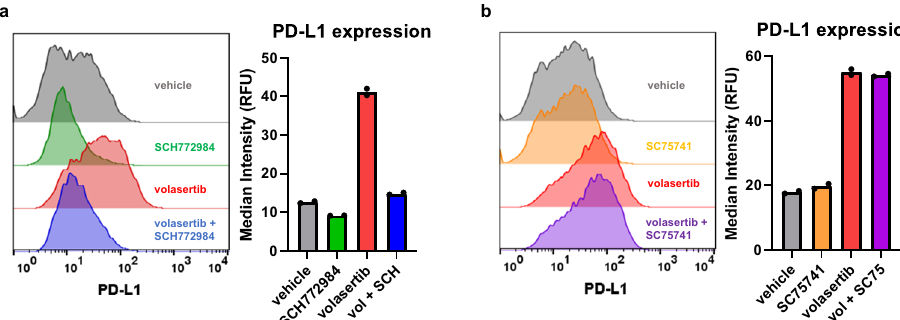
Fig. 2 Volasertib-induced PD-L1 upregulation is dependent on MAPK. a PD-L1 surface expression of NSCLC cells (H460) treated with vehicle control (0.1% DMSO in PBS), SCH772984 (ERK1/2 small molecule inhibitor, 1 μ M), volasertib (100 nM), or SCH772984 (SCH; 1 μ M) + volasertib (vol; 100 nM) – (left) representative histograms, (right) MFI quanti fi cation. Data presented as mean MFI (median fl uorescent Intensity) from biological duplicates, 10,000 events collected per sample. b PD-L1 surface expression of H460 cells treated with vehicle control (0.1% DMSO in PBS), SC75741 (NF-kB inhibitor, 1 μ M), volasertib (100 nM), or SC75741 (SC75; 1 μ M) + volasertib (vol; 100 nM) – (left) representative histograms, (right) MFI quanti fi cation. Data presented as mean MFI from biological duplicates, 10,000 events collected per sample. Source data are provided as a Source Data fi le.